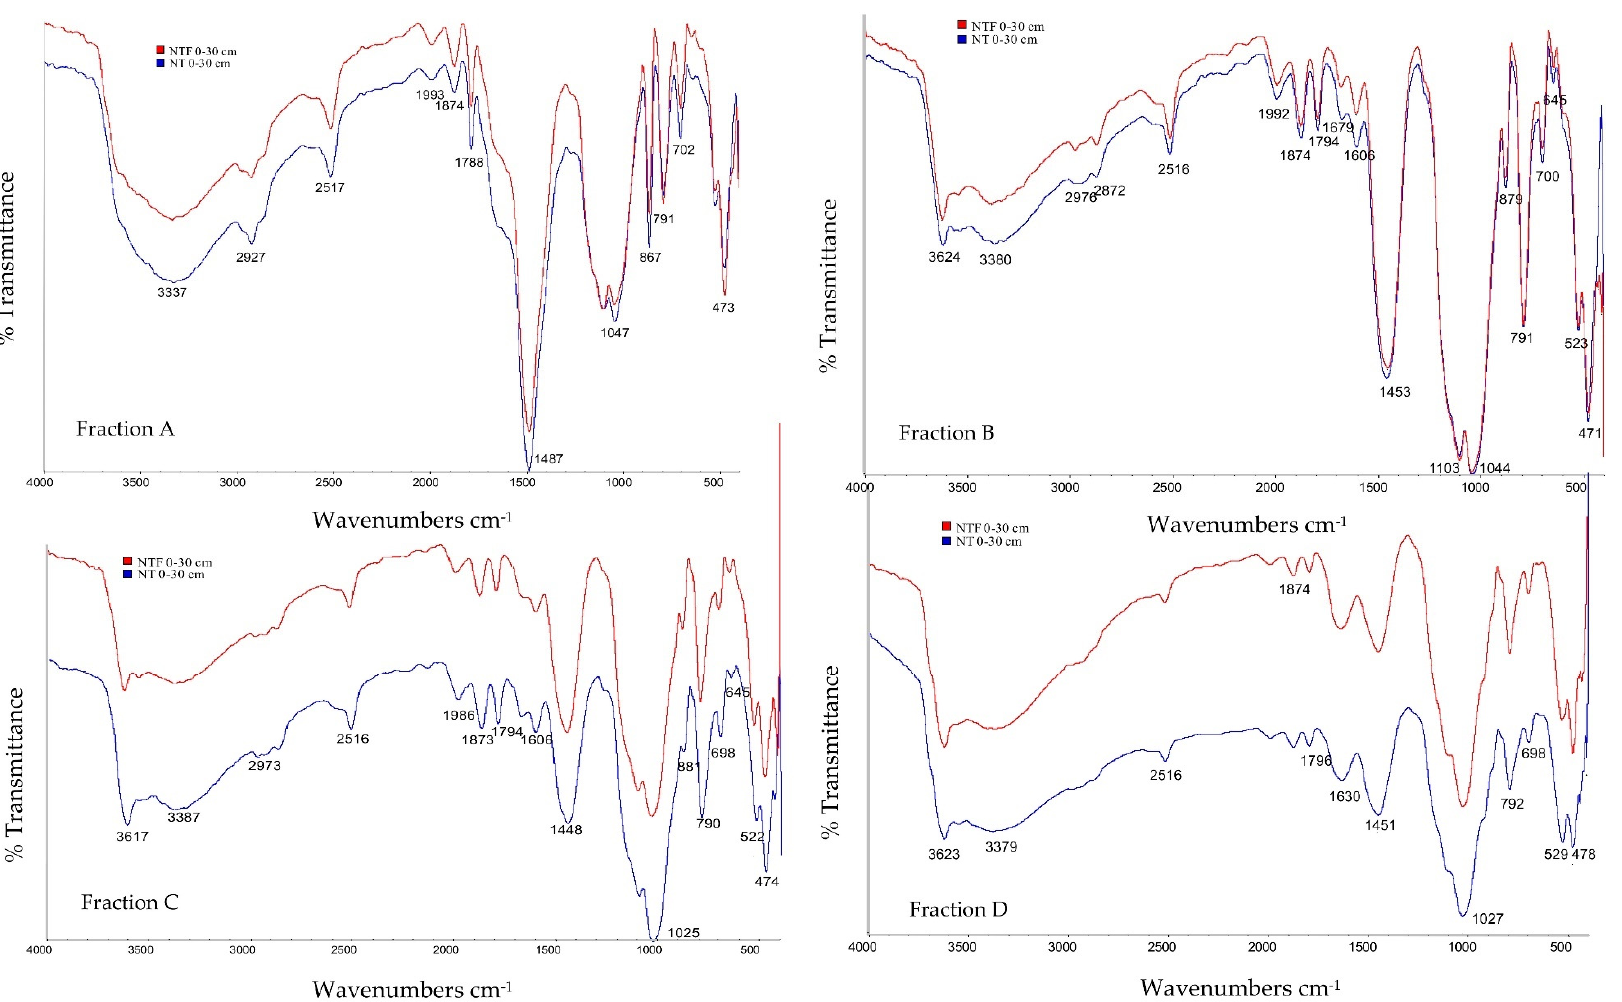
Figure 4. Diffuse reflectance infrared Fourier transform spectra of the different soil fractions (A, B, C, and D) isolated from no tillage (NT) treatment (0–30 cm) fertilized and not fertilized.